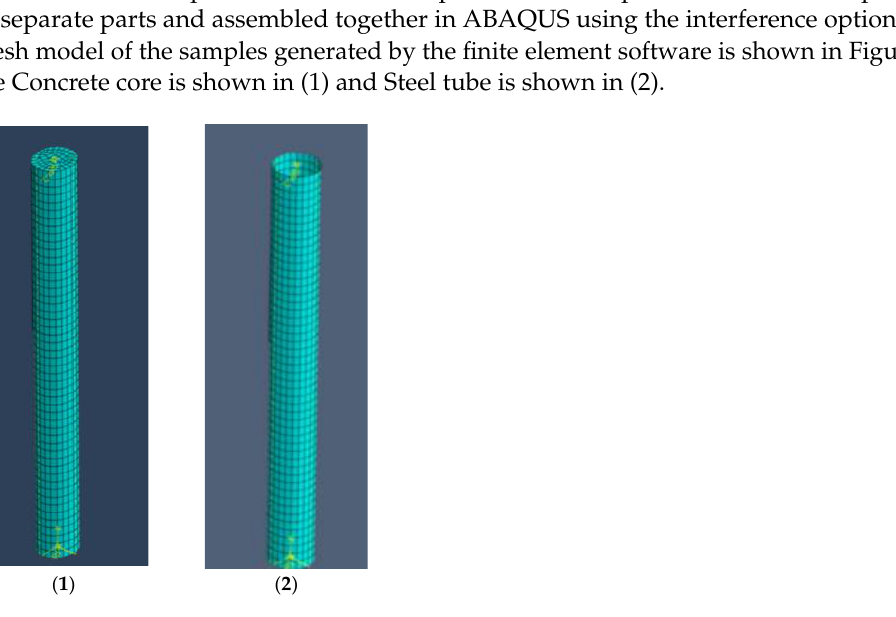
Figure 12. Meshing of concrete infilled steel columns. ( 1 ) Concrete core, ( 2 ) steel tube.